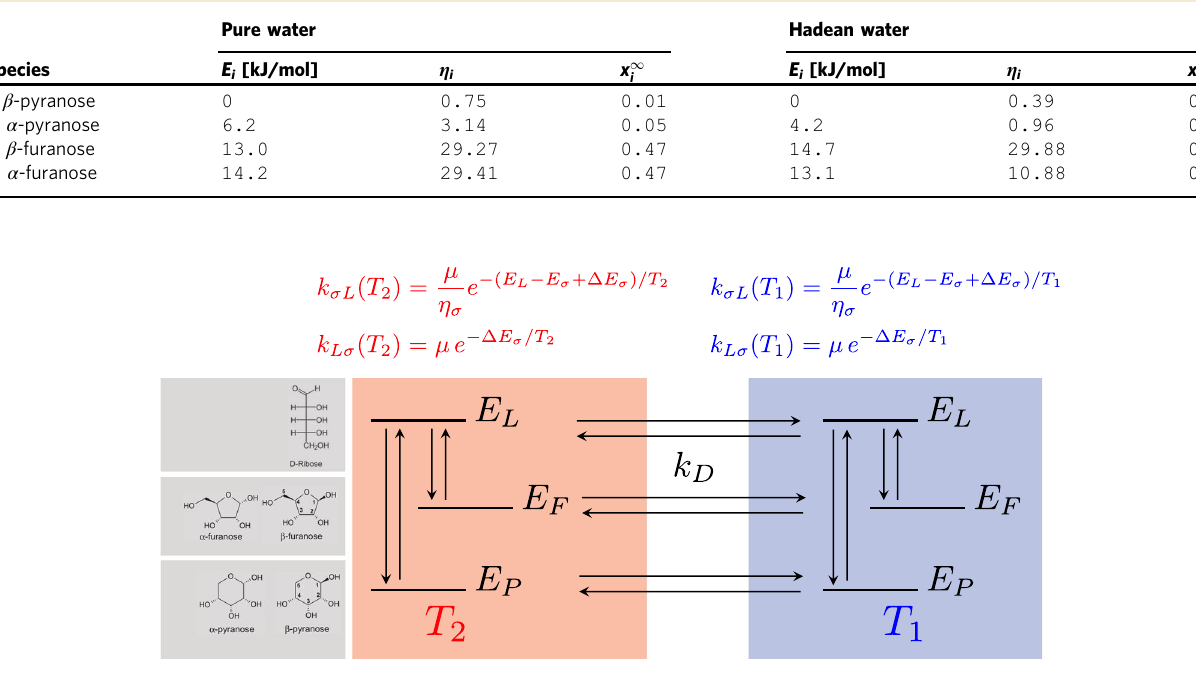
Fig. 3 Simple model of ribose isomerisation in a steady temperature gradient ( T 2 > T 1 ). The highest-energy linear species has energy E L , α F and β F have been coalesced into the high-energy state F (energy E F ), while α P and β P are coarse-grained into the ground state (and reference energy), E P . Chemical rates are expressed as the product of a velocity, μ , and an Arrhenius term that depends on the energy barriers Δ E σ ( σ = F , P ) and include entropic degeneracy factors, η σ , in accordance with our experimental fi